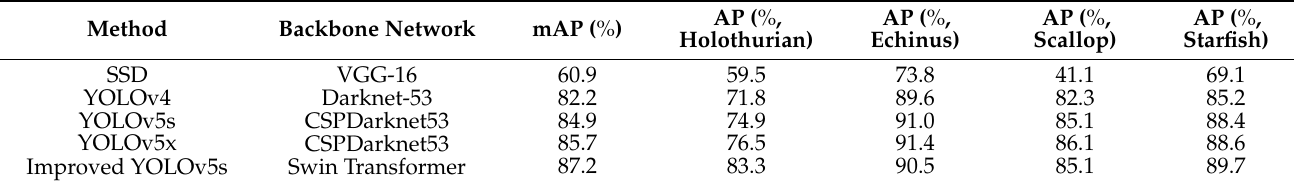
Table 5. Experimental results of different